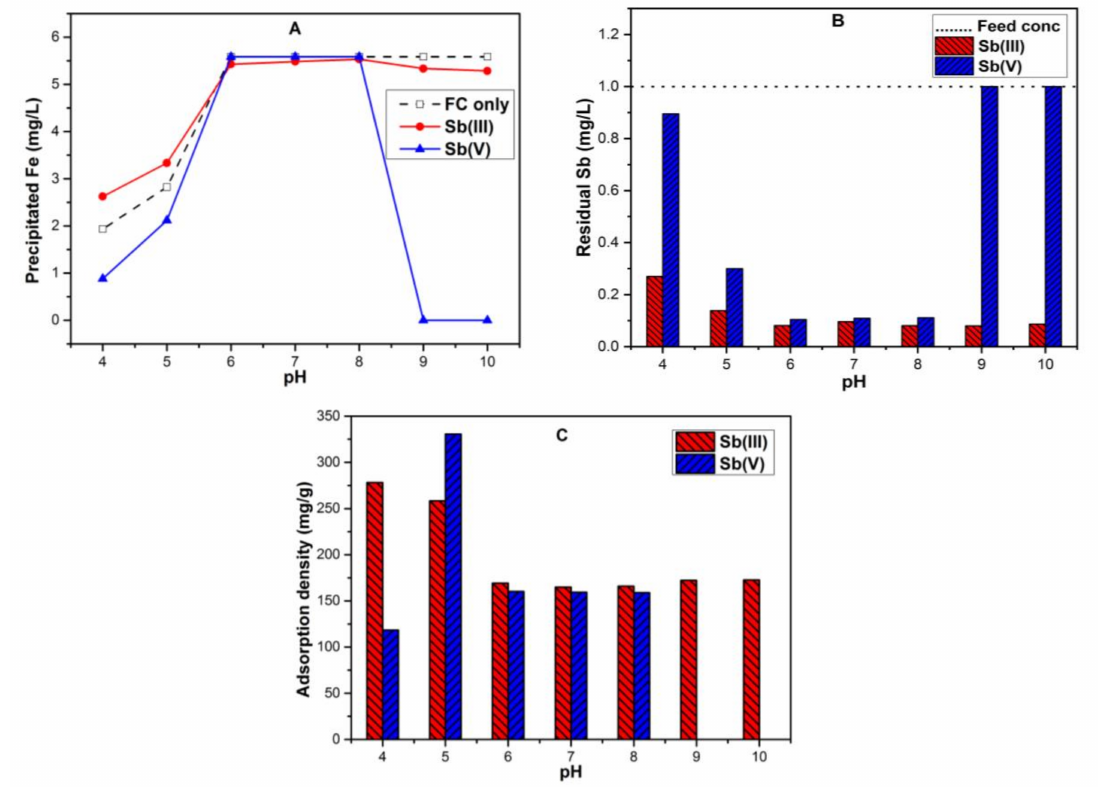
Figure 1. Across various pH in the range 4–10, 0.1 mM ferric chloride coagulation (FC) dose, 1 mg/L initial Sb concentration and temperature T 25 ± 1 ◦ C showing ( A ) Fe precipitation (mg/L); ( B ) residual Sb (mg/L); ( C ) adsorption densities